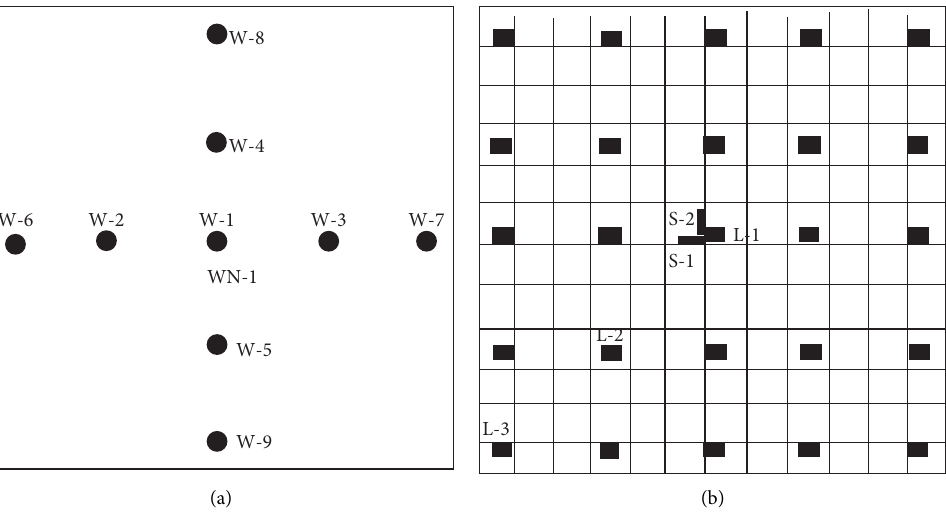
Figure 3: Layout of measuring points. (a) Displacement points. (b) Strain measuring points for steel bars and connectors.